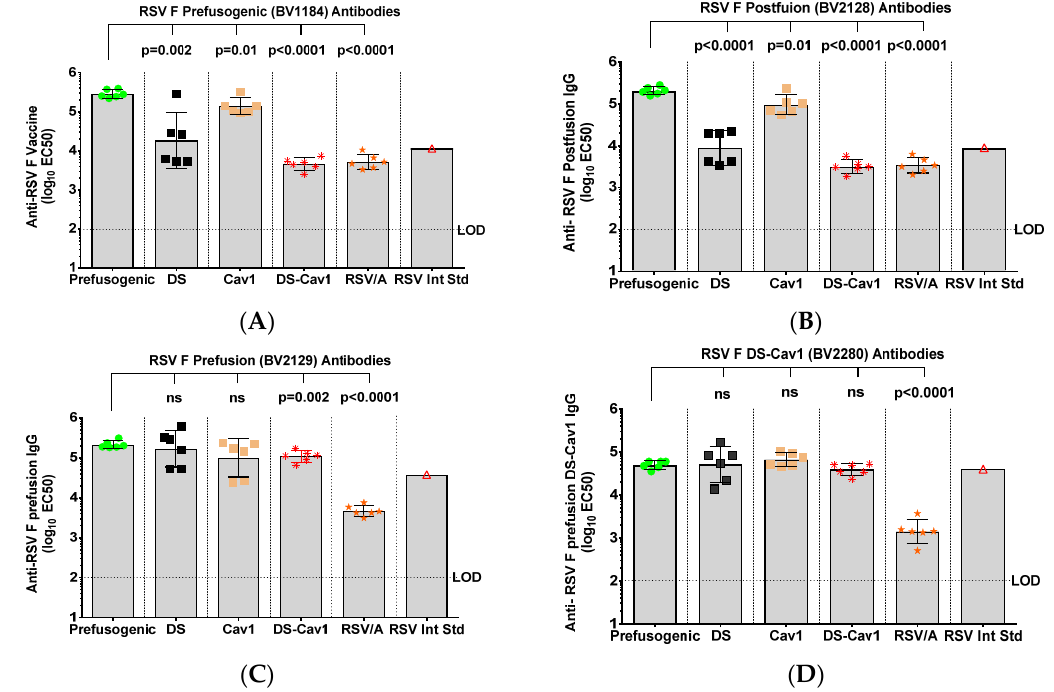
Figure 4. Immunogenicity of prefusogenic F and F variants in cotton rats. Cotton rats were immunized by intramuscular injection with 1.0 µg of prefusogenic F vaccine (BV1184), DS (BV2267), Cav1 (BV2279), DS-Cav1 (BV2280) or postfusion F (BV2128) with 30 µg aluminum phosphate on days 0 and 21. A comparative control group was intranasal challenged with 10 6 pfu RSV/A Long. Serum was collected for analysis 21-days after the second immunization (day 42). ( A ) Anti-prefusogenic F vaccine IgG (BV1184). ( B ) Anti-postfusion F IgG (BV2128). ( C ) Anti-prefusion F IgG (BV2129). ( D ) Anti-DS F IgG (BV2280). Not significant (ns). Symbols indicate antibody titers for individual animals in each immunization group. Bars indicated the geometric mean titer (GMT) and the error bars indicate the ± 95% CI. Statistical significance between the prefusogenic F (BV1184) compared to paired groups. Limit of detection (LOD). Not significant (ns).